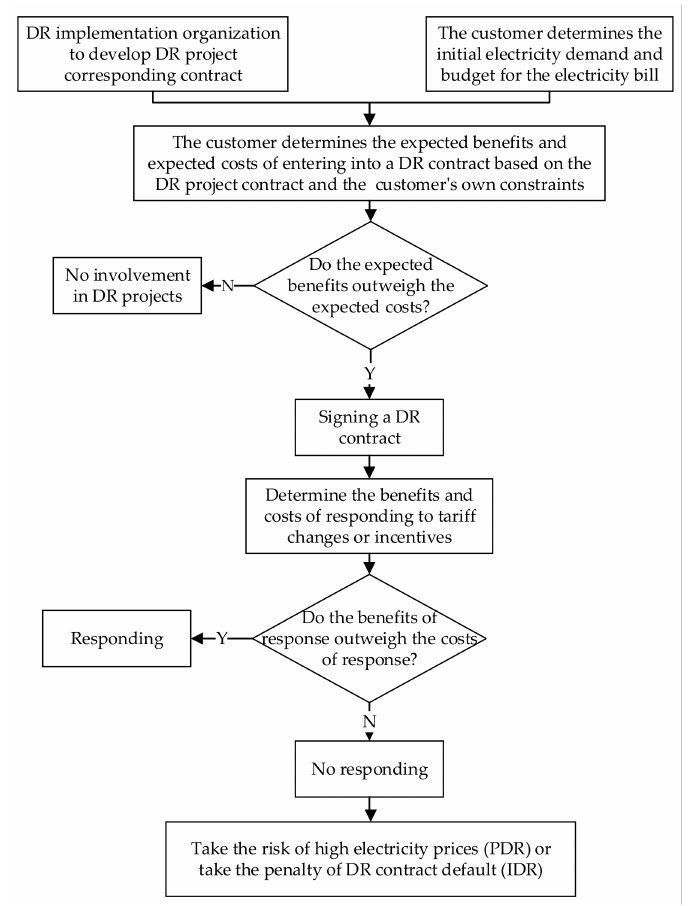
Figure 1. Typical responding process of DR